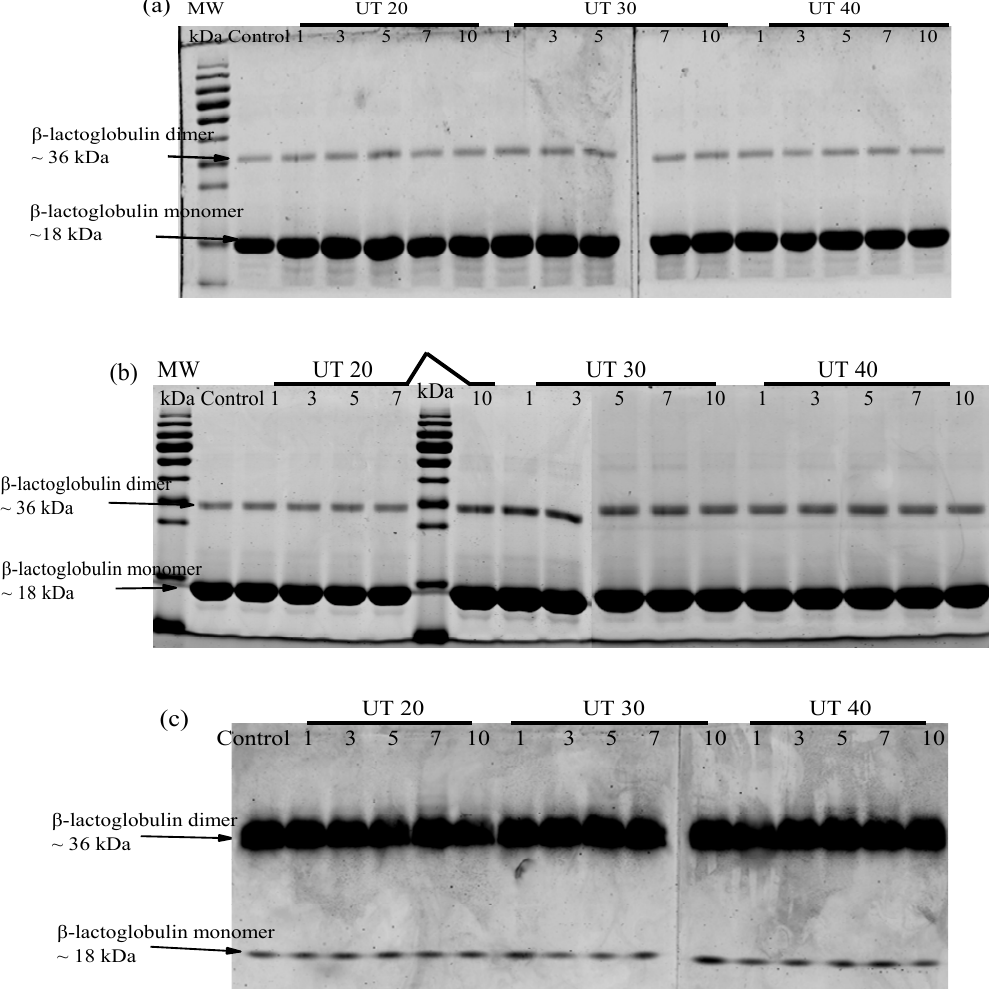
Figure 5. Effects of ultrasound treatment on molecular weight. ( a ) Reducing Sodium Dodecyl Sulfate (SDS) - Polyacrylamide Gel Electrophoresis (PAGE), ( b ) Non-reducing SDS-PAGE, ( c ) Native PAGE of goat milk β -lactoglobulin in different amplitudes (20%, 30%, 40%) and different treatment times (0, 1, 3, 5, 7, 10 min).